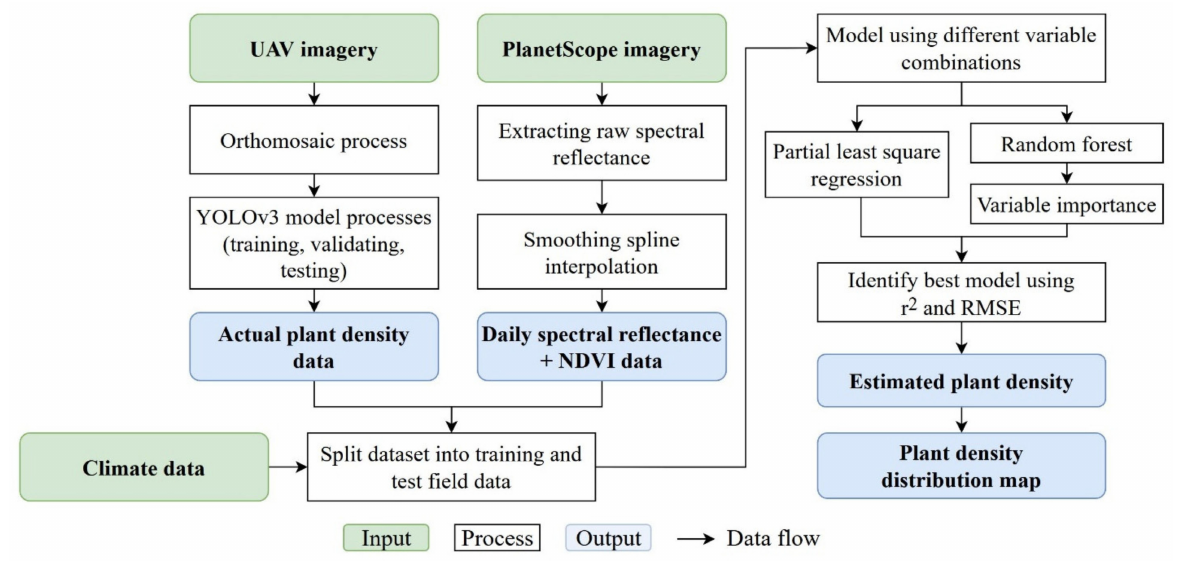
Figure 1. Flow chart of the research.